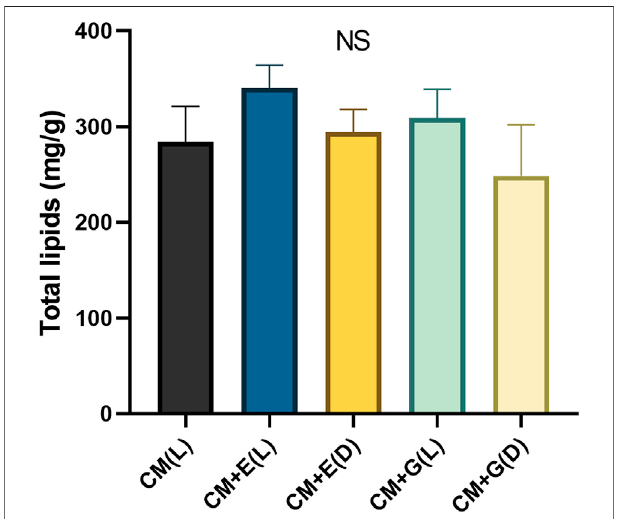
FIGURE 5 | Total lipid contents (mg/g dw) of E. gracilis 815 cultured under different conditions on Day 6. NS indicates no signi fi cant difference according to ANOVA test at p > 0.05.